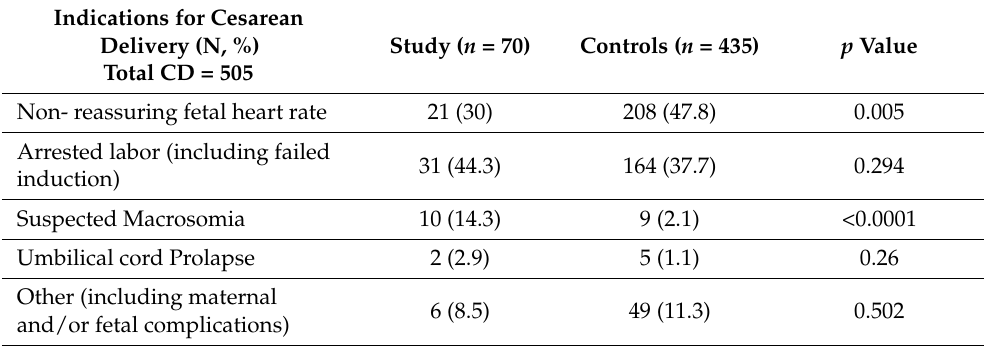
Table 2. Indications for cesarean